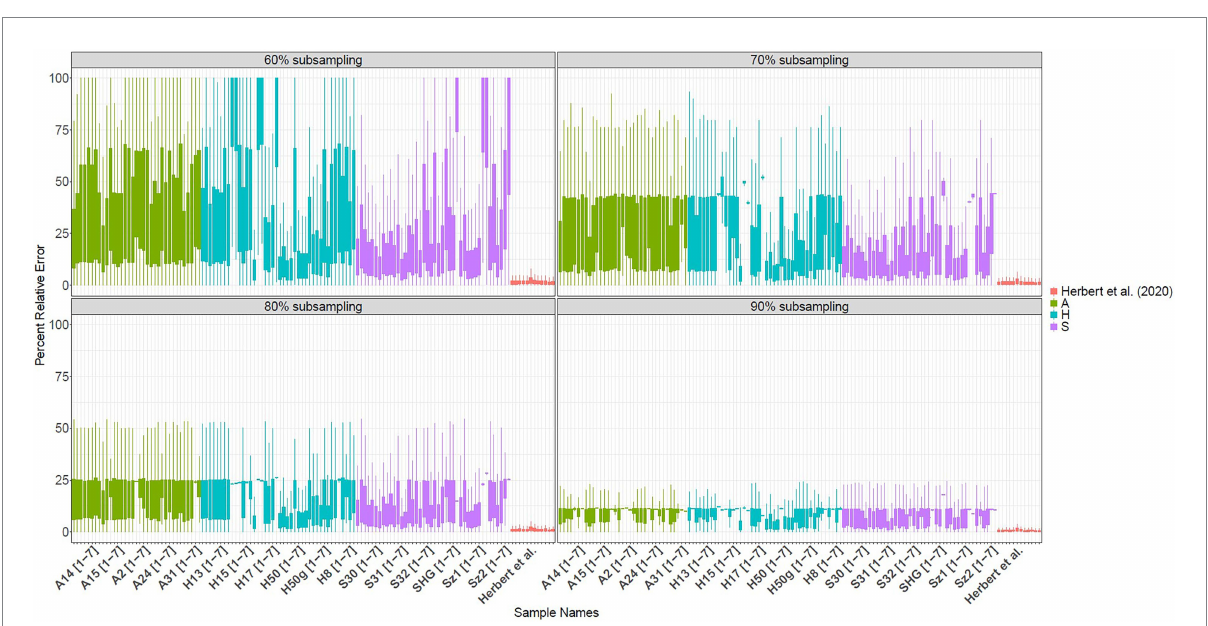
FIGURE 3 Error rates for the TPM normalized read counts for the samples of the mRNA-GBS analysis, depicted in light green (S), bluish green (H) and purple (A) and the RNA-Seq data of Herbert et al. (2021) in red, calculated with 90% coverage (upper left), 80% coverage (upper right), 70% (lower left), 60% (lower right) an revealing strong differences in the error rate detection in the mRNA-GBS samples, when coverage is reduced, with little differences in the RNA-Seq data, which is stable and thus usable for gene expression